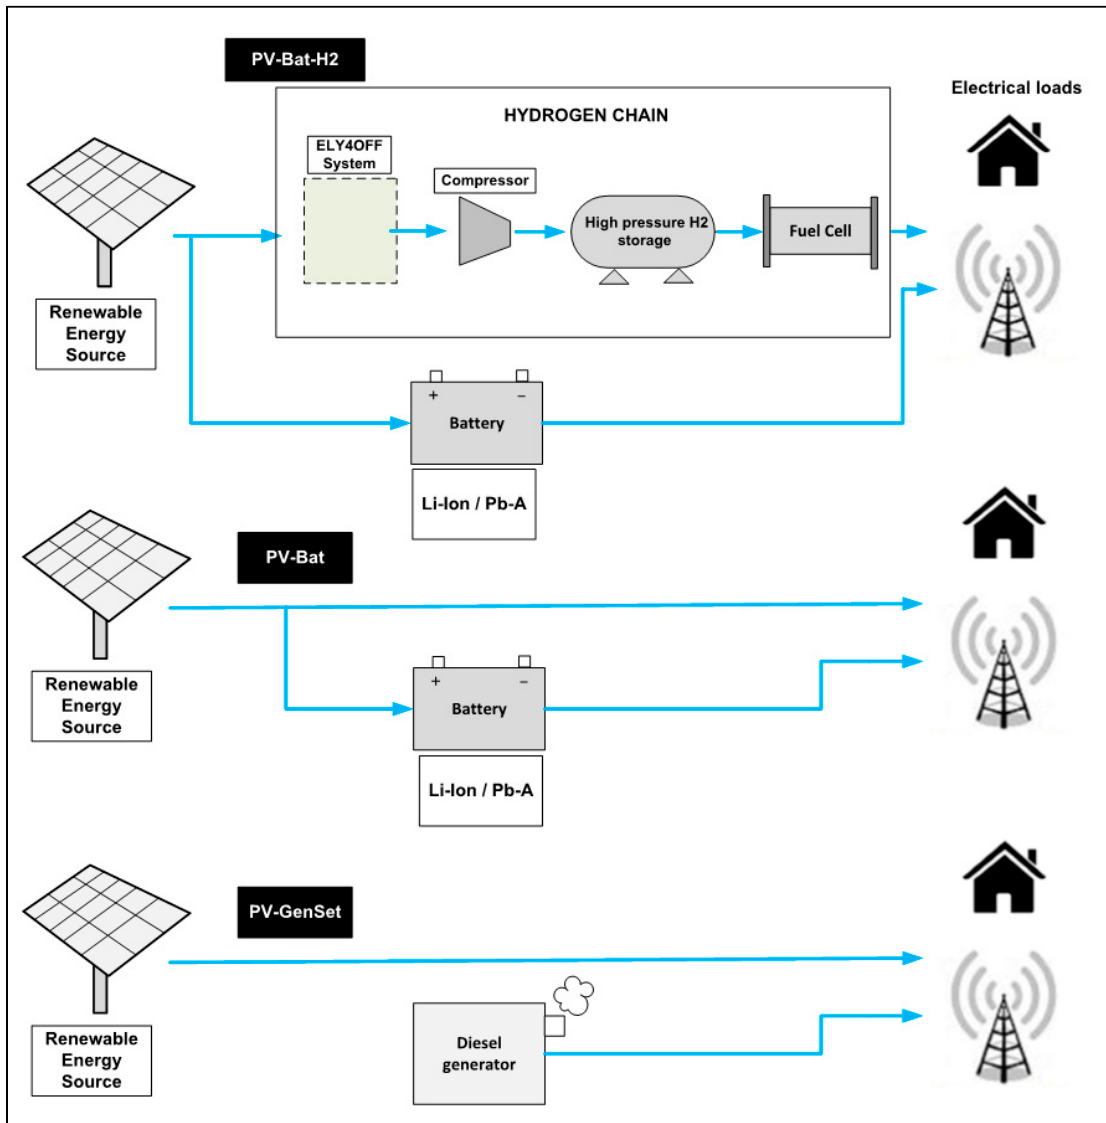
Figure 3. Systems in competition with Ely4off (diesel generator is not represented due to its simplicity).